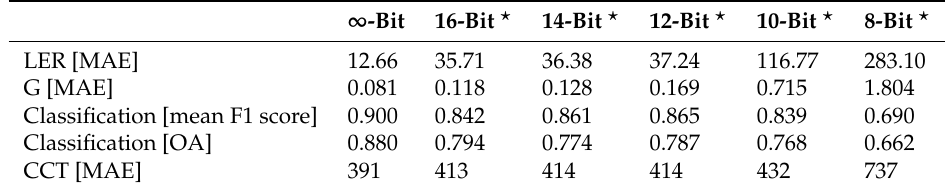
Table 4. Performance comparison for different bit depths, detection limit, and saturation considering B0-B5. (cid:63) slightly different detection limit and saturation are considered. Overall accuracy (OA) is the total number of correctly classified instances divided by the total number of instances. ∞